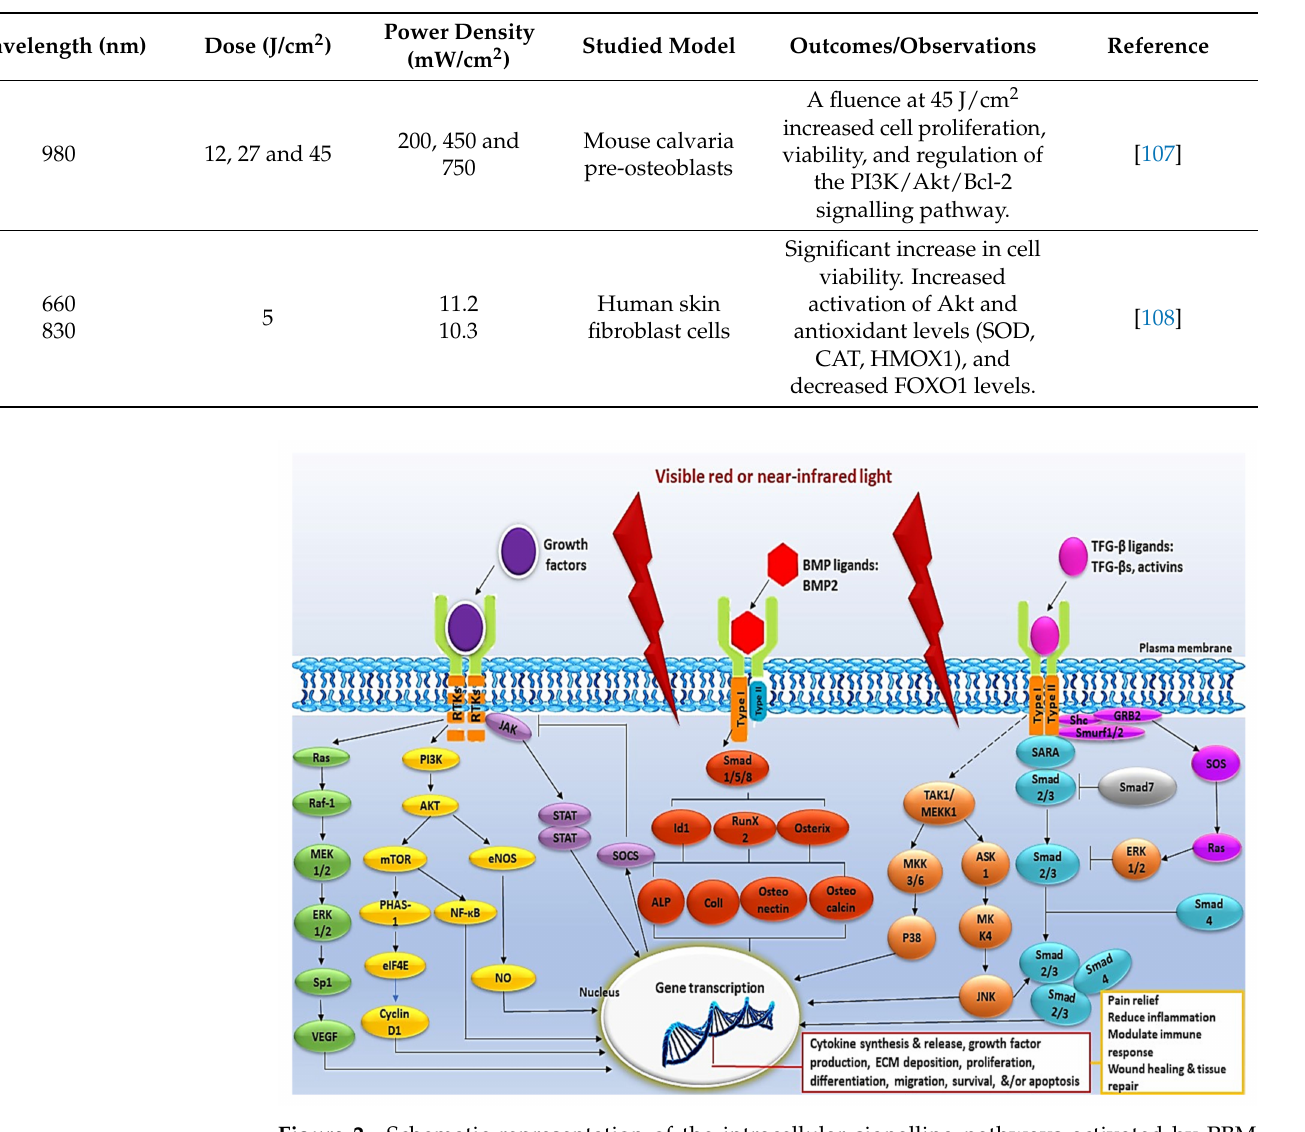
Figure 2. Schematic representation of the intracellular signalling pathways activated by PBM. The intracellular signalling pathways activated by PBM include the MAPK, PI3K/Akt/mTOR, JAK/STAT, BMP/Smad, and TFG- β /Smad pathway. Intracellular signalling pathways are acti- vated in response to a wide array of extracellular signals and are frequently activated in parallel. They are integrated by positive and negative feedback and generate numerous biological signals that depend on the stimulus and on the activated cell